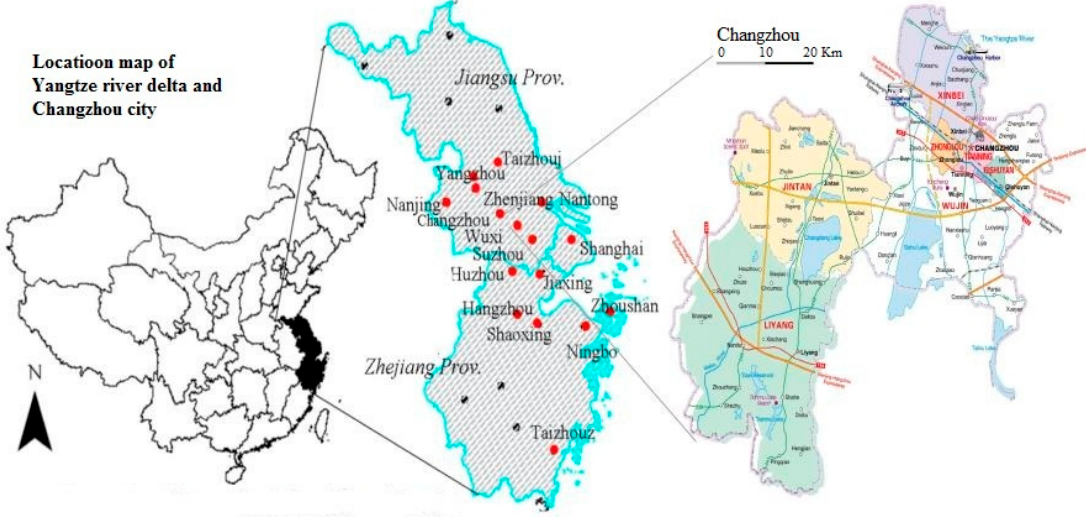
Figure 2. Geographical location of Changzhou city in the Yangtze River delta region, China.